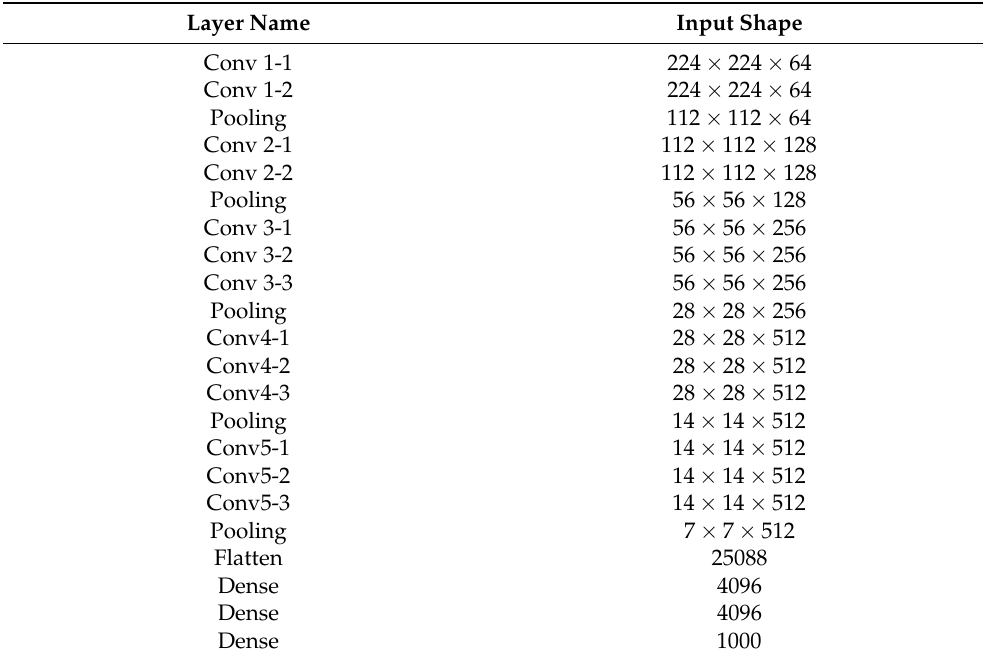
Table 5. VGG16 layers.